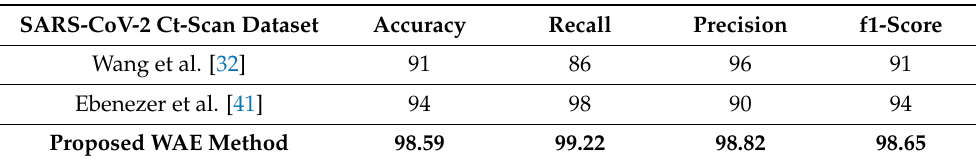
Table 9. Comparing the proposed WAE method with methods proposed in previous studies on the SARS-CoV-2 CT-scan dataset [42].